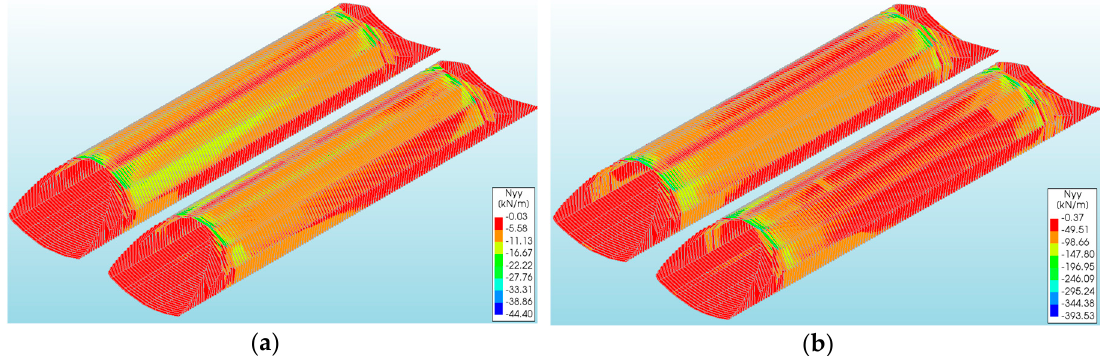
Figure 10. Maximal values of axial forces of: ( a ) Rockburst for model Ia, ( b ) El Centro for model IIIb.